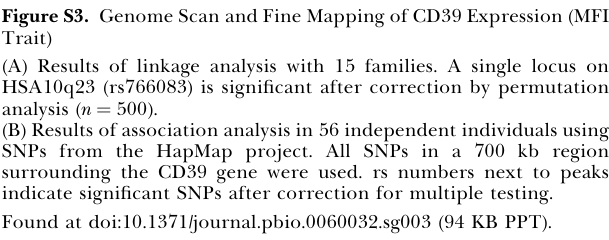
Table S1. Infectivity of HIV.GFP of Cells Transfected with or Silenced for the Gene of Interest from the LY6/uPAR Family Values reflect relative infectivity to that of the mock control. None of the differences are statistically significant. Found at doi:10.1371/journal.pbio.0060032.st001 (26 KB